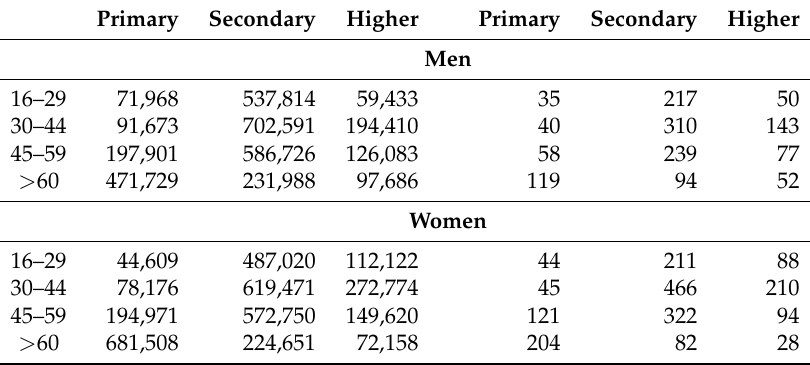
Table 4. Education level by sex and age at population and panel